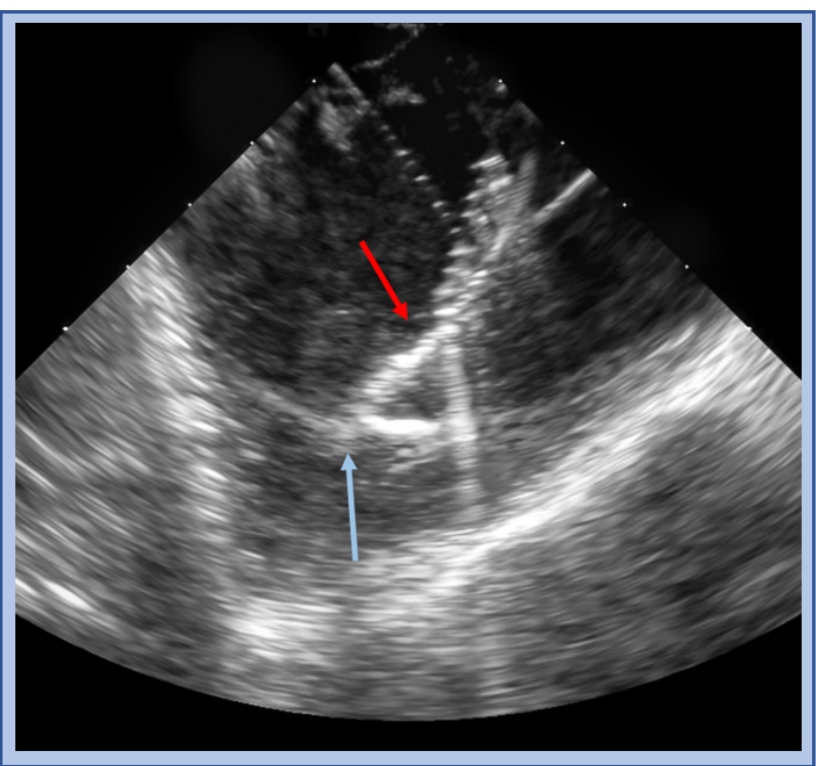
Figure 16. ICE image of a cryo catheter (red arrow) balancing on and adherent to moderator band (blue arrow). Table 5. Summary of moderator band ablation